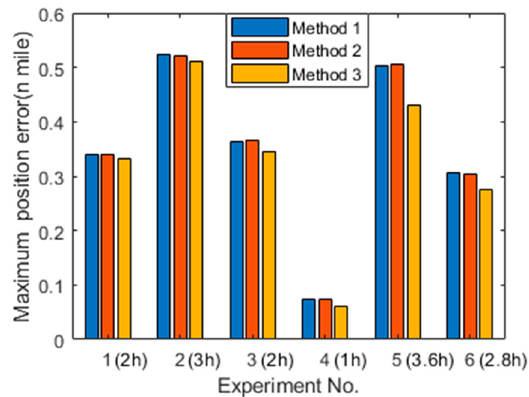
Figure 10. The position errors of multiple navigation experiments.